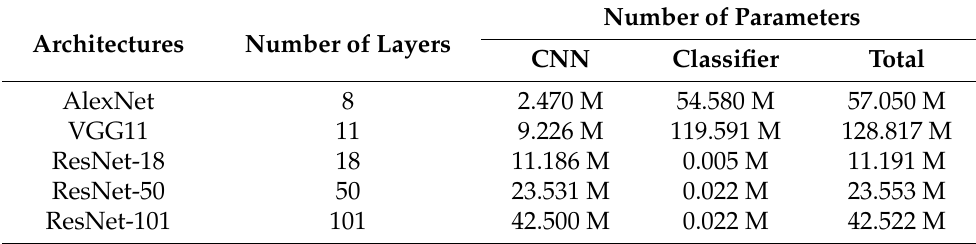
Table 1. Comparison of the number of parameters and layers by deep learning model